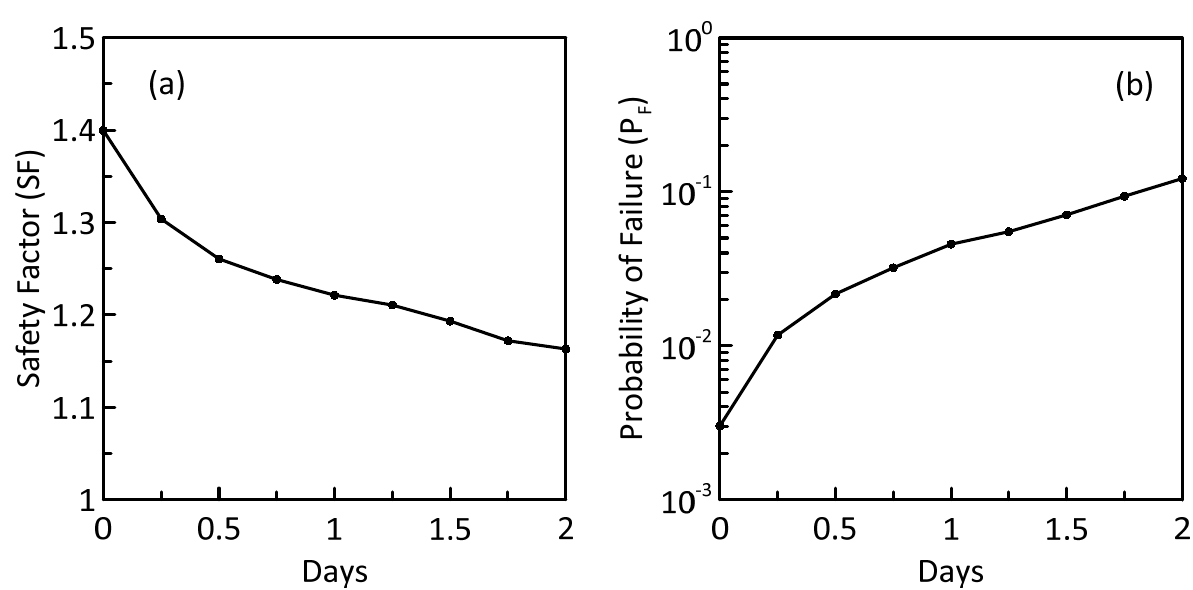
Figure 3. Evolution of ( a ) the safety factor and ( b ) the probability of failure of an open-pit slope during rainfall.